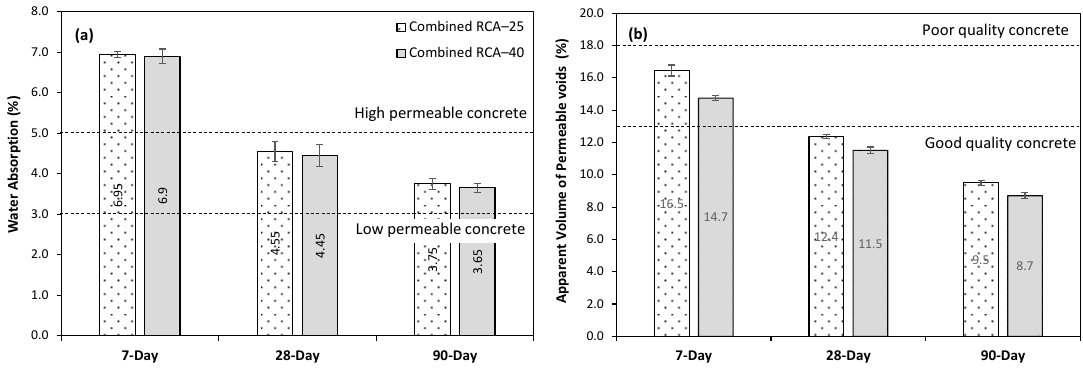
Figure 6. ( a ) Water absorption and ( b ) apparent volume of permeable void (AVPV) of combined RCA concrete.